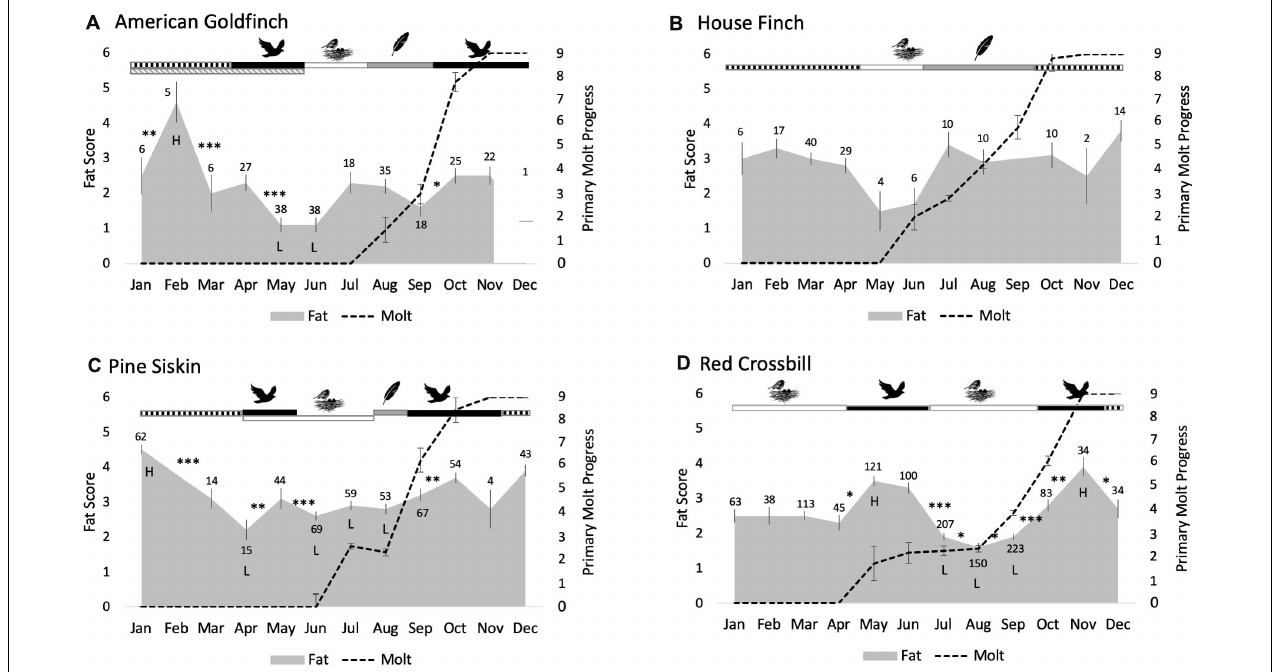
FIGURE 2 | Changes in fat and molt progress across month and life cycle stages in free-living American goldfinches (A) , house finches (B) , pine siskins (C) , and red crossbills (D) . Average fat score (gray contour plots) +/– S.E.M. and average number of primaries that have been replaced (dashed line) +/– SEM given for each calendar month. Significant changes in fat score between consecutive months detected by the LMM are indicated by asterisks ( ∗ P < 0.05, ∗∗ P < 0.001, ∗∗∗ P < 0.0001) and the highest and lowest levels are indicated by the letters H and L (identified by Tukey comparison of means P < 0.05). Dominant life cycle stages for each month are shown above the plots, including: overwintering (hatched black bars), migration (black bars), breeding (open bars), prealternate molt (hatched gray), and periods with exclusive primary molt (gray bars). Sample sizes are indicated above each monthly average.